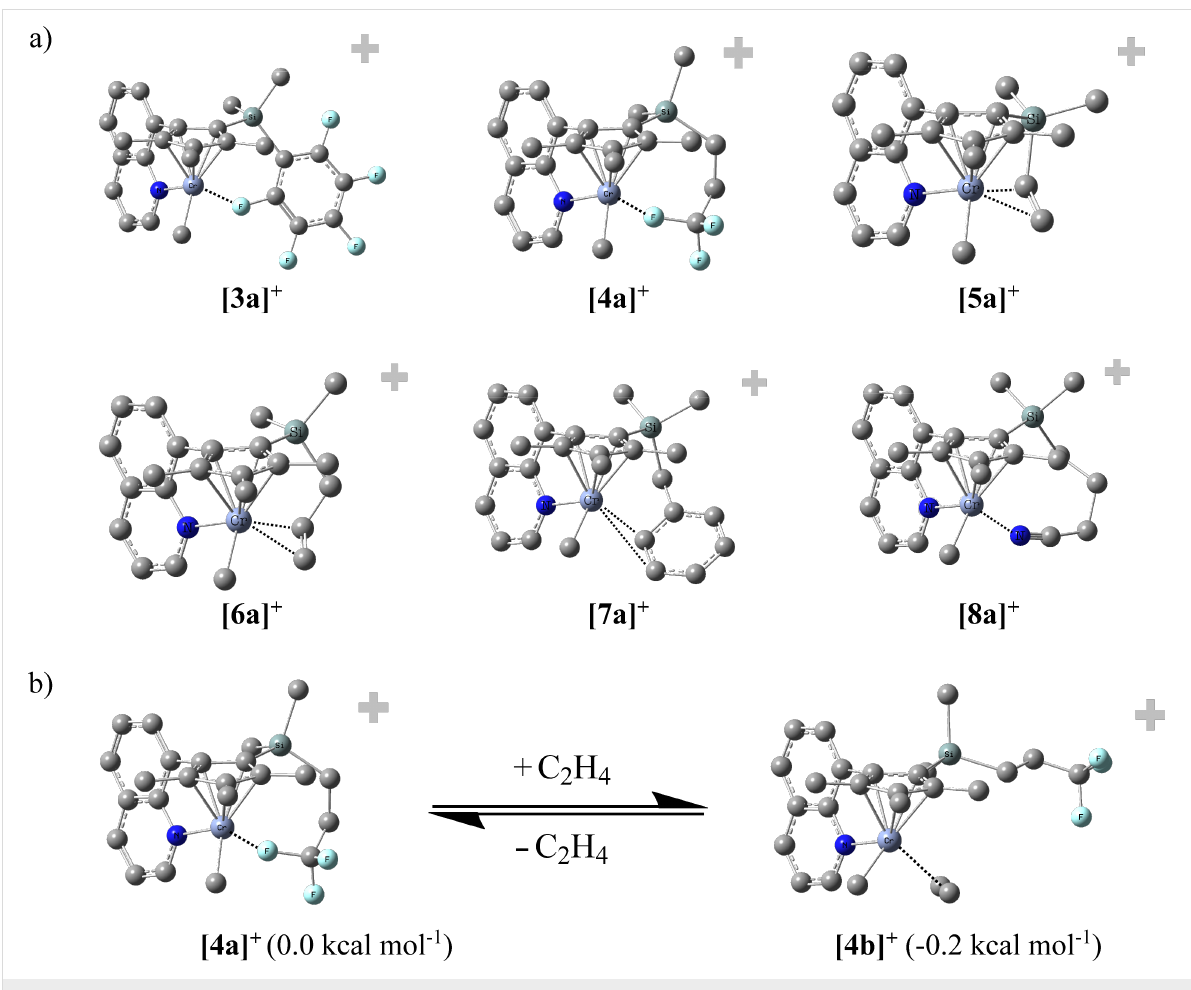
Figure 2: a) Calculated structures of cationic chromium complexes. Chromium–donor distances [Å]: 3a + [2.21], 4a + [2.24], 5a + [2.53/2.51], 6a + [2.75/ 2.46], 7a + [2.58/3.17], 8a + [2.06]. b) Displacement of hemilabile donor by ethylene under formation of the ethylene complex 4b + . (Energies for the for- mation of the analogous ethylene complexes 3b + [ − 1.3], 5b + [ − 4.5], 6b + [+2.9], 7b + [ − 2.9], 8b +